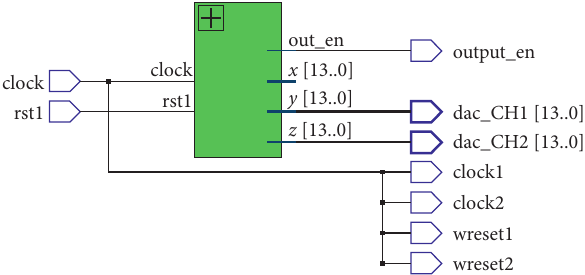
Figure 3: Register transfer level viewer when field programmable gate array implements the multiscroll chaotic